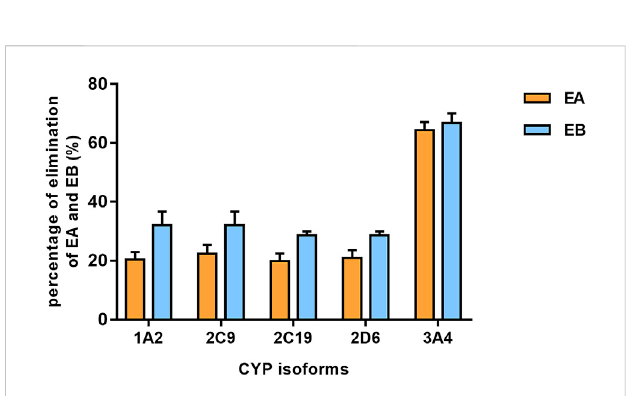
FIGURE 9 The elimination percentage of EA and EB after incubation with various cDNA-expressed human CYP isoforms for 30 min at10 μ mol L − 1 (mean ± SD; n =